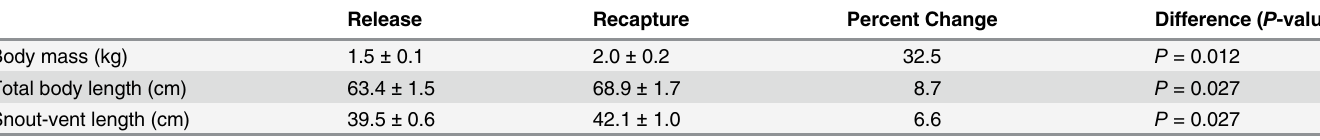
Table 2. Biometric measurements (Mean ± SE) of recaptured Chinese giant salamanders (n = 8) at the beginning and the end of the